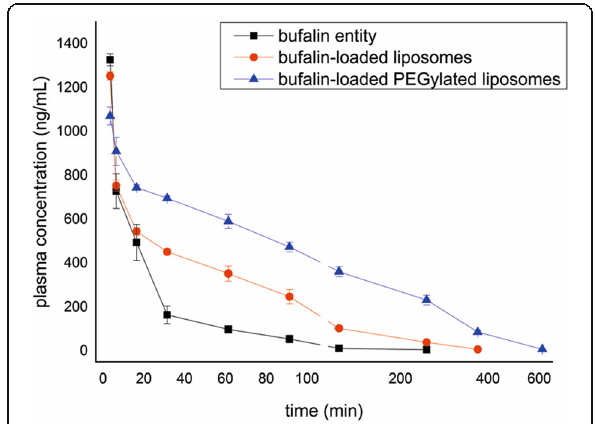
Fig. 4 Concentration-time curve of bufalin in plasma in